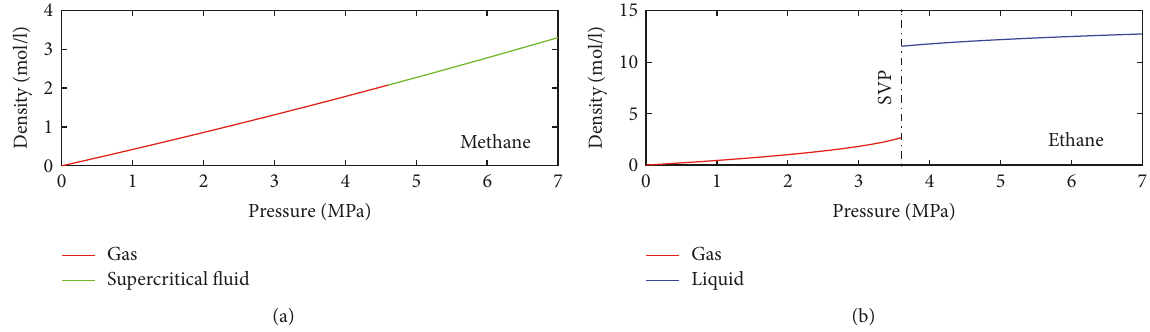
Figure 1: Isothermal density-pressure relationships for methane (a) and ethane (b) at laboratory temperature (18 ∘ C). SVP is saturated vapour pressure. Data from Lemmon et al., 2017.